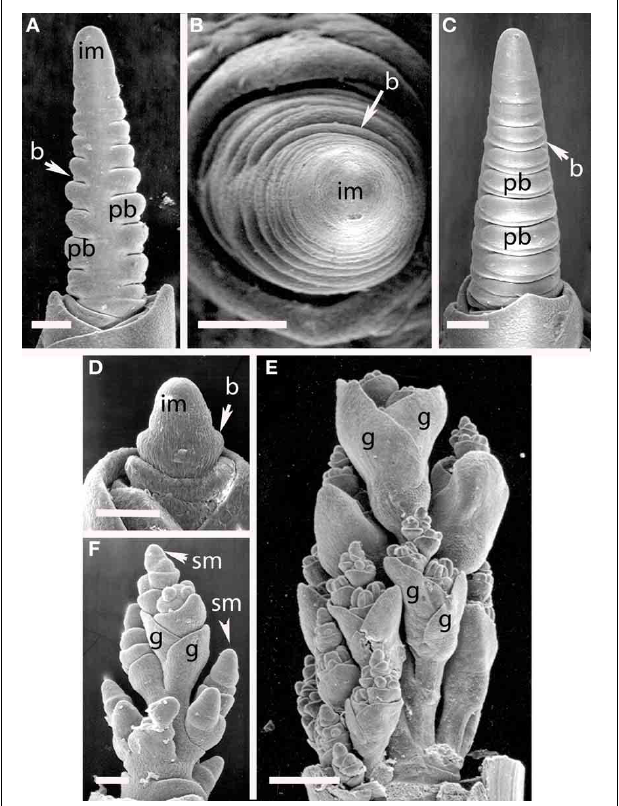
FIGURE 10 | (A–C) Hordeum vulgare (Triticeae). (A,C) Distichous bracts with broad primary branch primordia in their axils; (B) distichous bracts. (D–F) Avena sativa (Poeae). (D) distichous bract formation shortly after the transition to flowering; (E) , early development of the terminal spikelet; (F) , later stage of spikelet development, with additional branching obscuring the primarily distichous pattern. im, inflorescence meristem; pb, primary branch; b, bract; sm, spikelet meristem; g, glume. Scale bars: (A–E) , 100 µ m, (F) , 500 µ